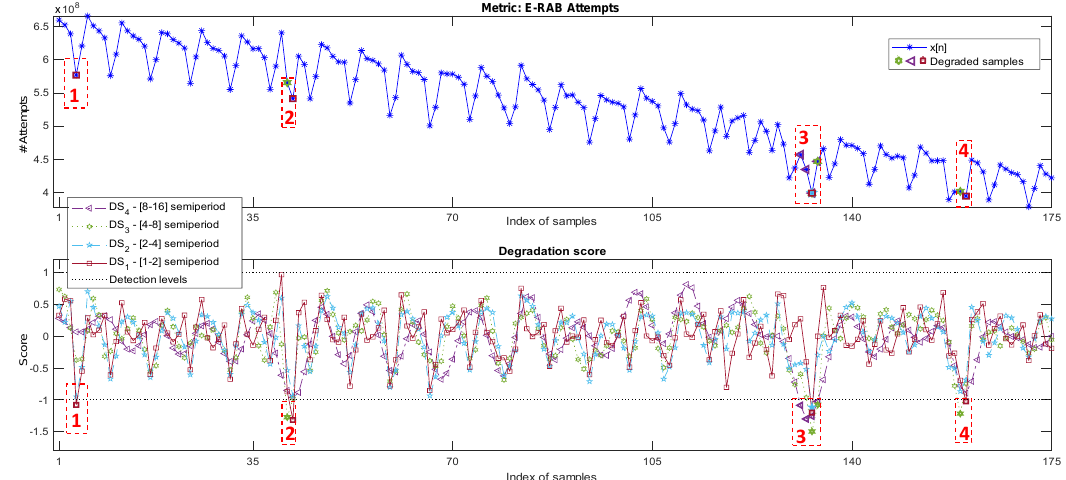
Figure 14. The E-RABattempts daily metric and its decomposition and detection